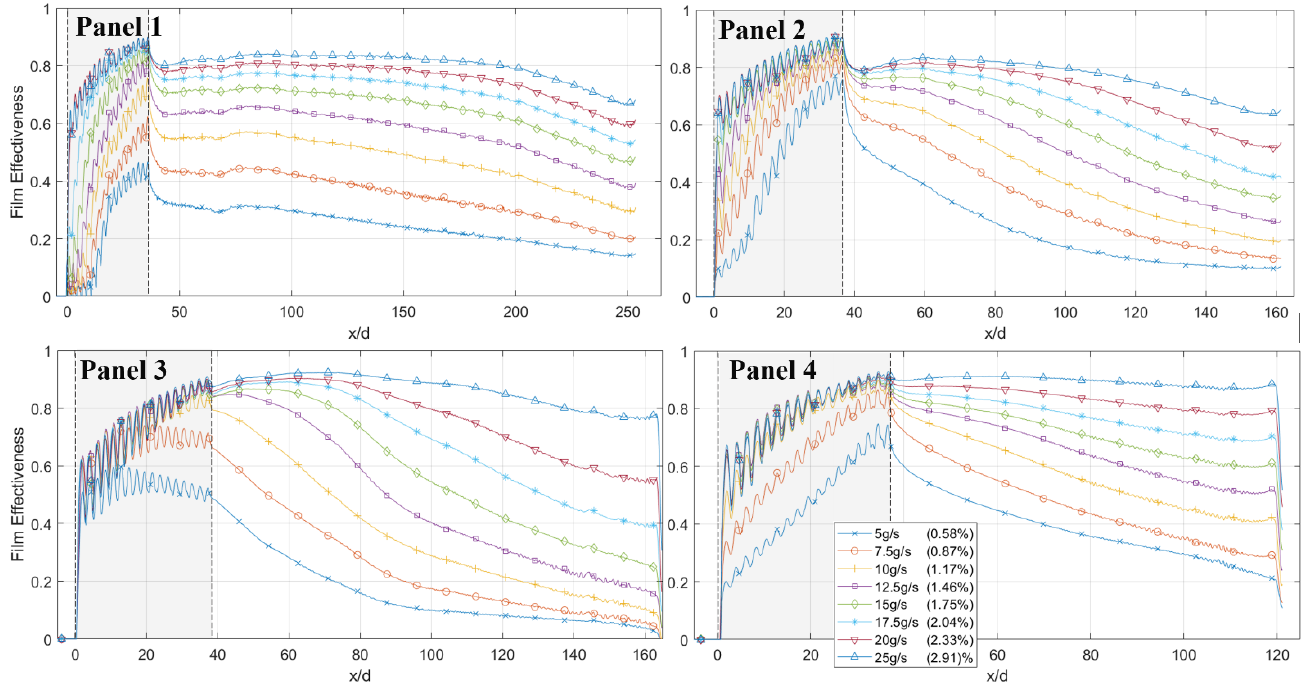
Figure 6. Spanwise average film effectiveness of Panels 1, 2, 3 and 4 at different coolant mass flow rates.